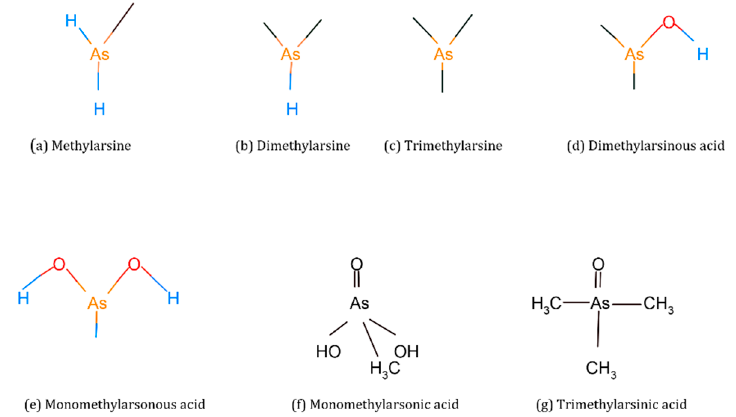
Figure 3. Chemical structures of organic arsenic species.